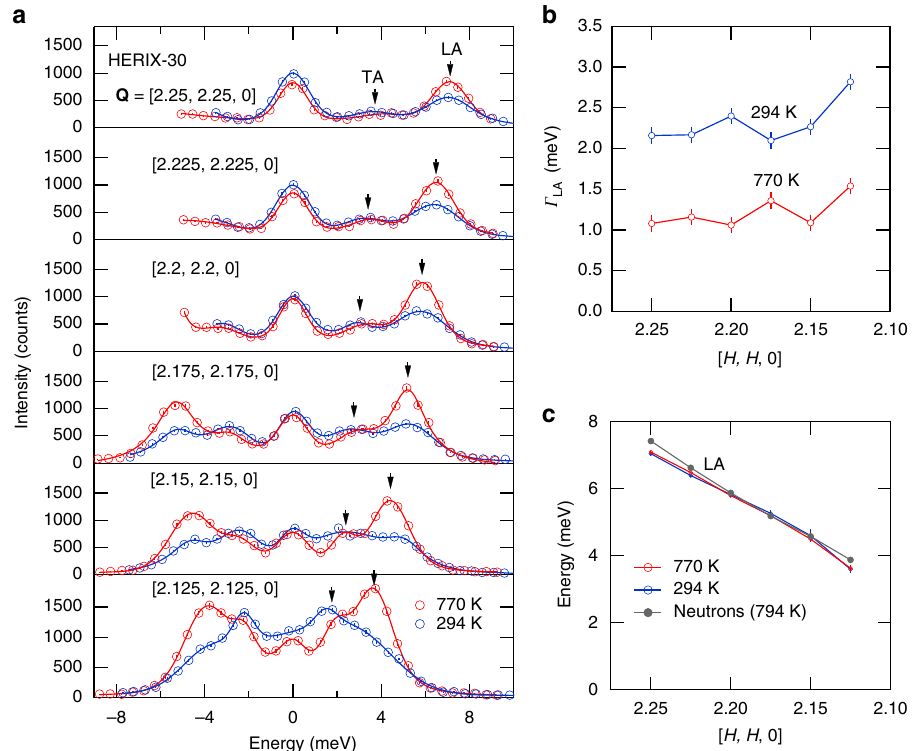
Fig. 3 Phonon sharpening measured using inelastic x-ray scattering. These measurements provide an essentially background free measure of the anomalous sharpening longitudinal acoustic (LA) phonon at high temperatures in Fig. 1e, f. a Spectrum at T = 294 and 770 K (circles) along with fi ts (lines) to the data. Error bars are statistical and represent one s.d. The transverse acoustic (TA) mode also appears but is weaker than with the triple axis measurements (Fig. 1e, f) because of a better out-of-plane Q resolution. b Resolution corrected energy linewidths for the LA phonon, Γ LA , full width at half maximum (FWHM). c The LA phonon dispersion showing good agreement with the triple-axis neutron results